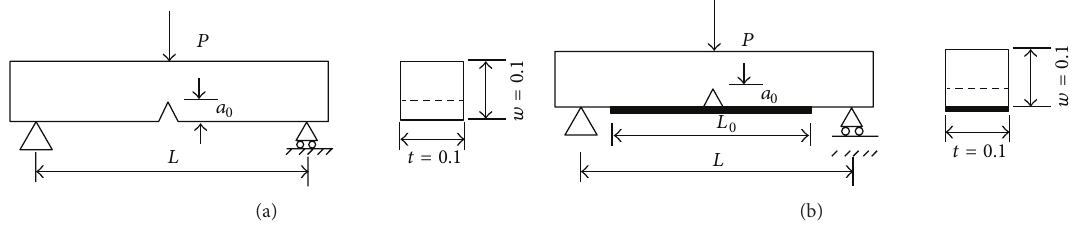
Figure 3: The geometrical model of the concrete beam. (a) The plain concrete beam. (b) The beam strengthened with CFRP.